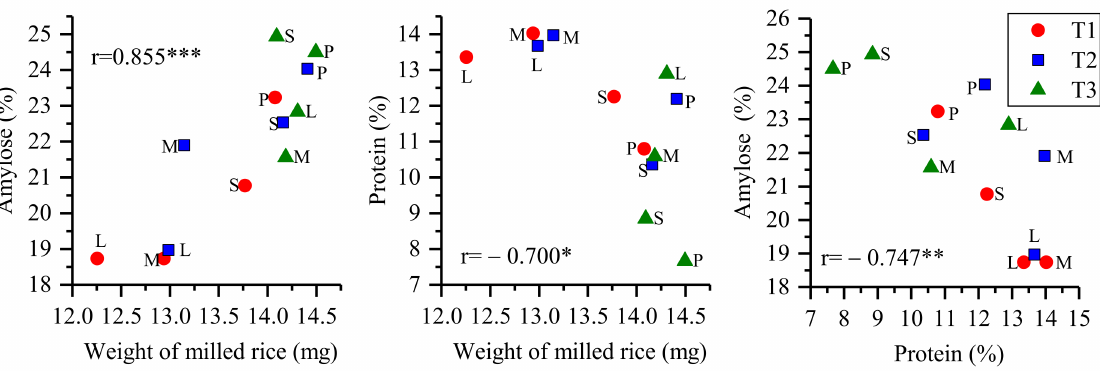
Figure 1. Relationship between weights of milled rice, protein, and amylose. *, **, and *** respectively denote significant correlations at p < 0.05, p < 0.01, and p < 0.001. P, S, M, and L indicate 0, 0–15, 15–40, and > 40% chalky ratio, respectively.